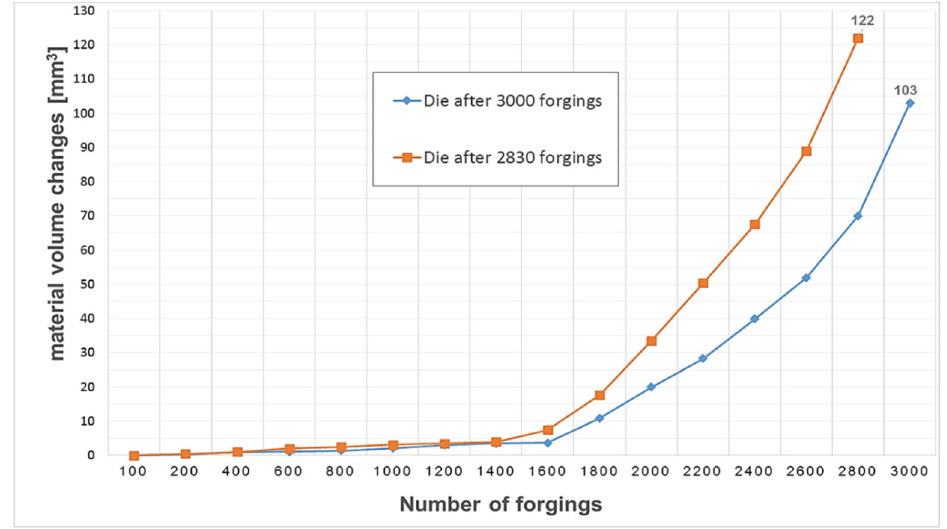
Figure 19. Volume changes–loss of material for the selected tools calculated from forgings.